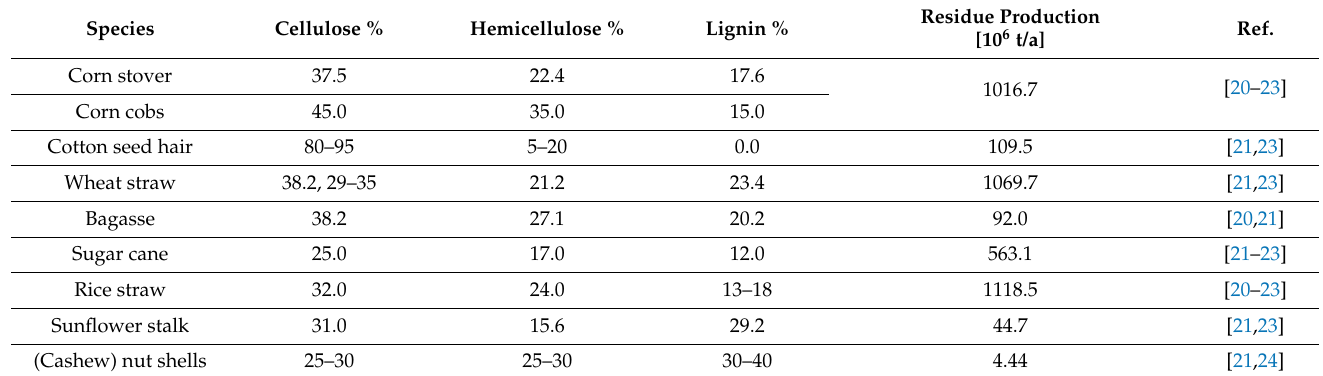
Table 1. Overview of lignocellulosic biomass composition and